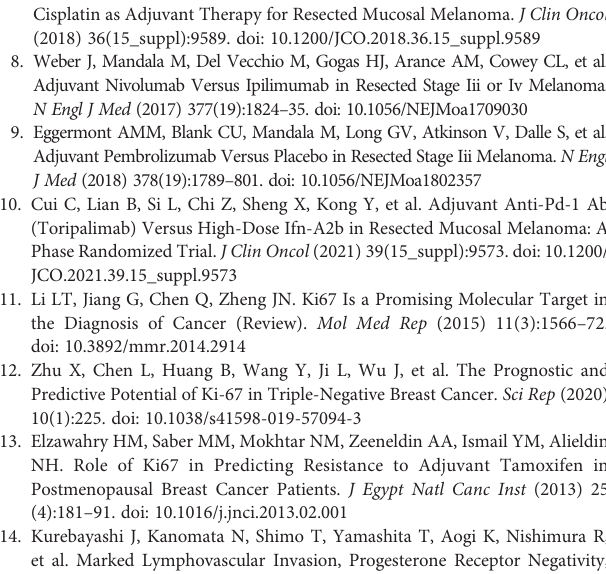
Supplementary Figure 1 | Kaplan-Meier curves of RFS (A) and MSS (B) according to adjuvant regimens in patients in the Ki67 low group (<30%). Kaplan- Meier curves of RFS (C) and MSS (D) according to adjuvant regimens in patients in the Ki67 high group (>=30%). Abbreviations: RFS, relapse-free survival; MSS, melanoma-speci fi c survival; TMZ, temozolomide; HDI, high-dose